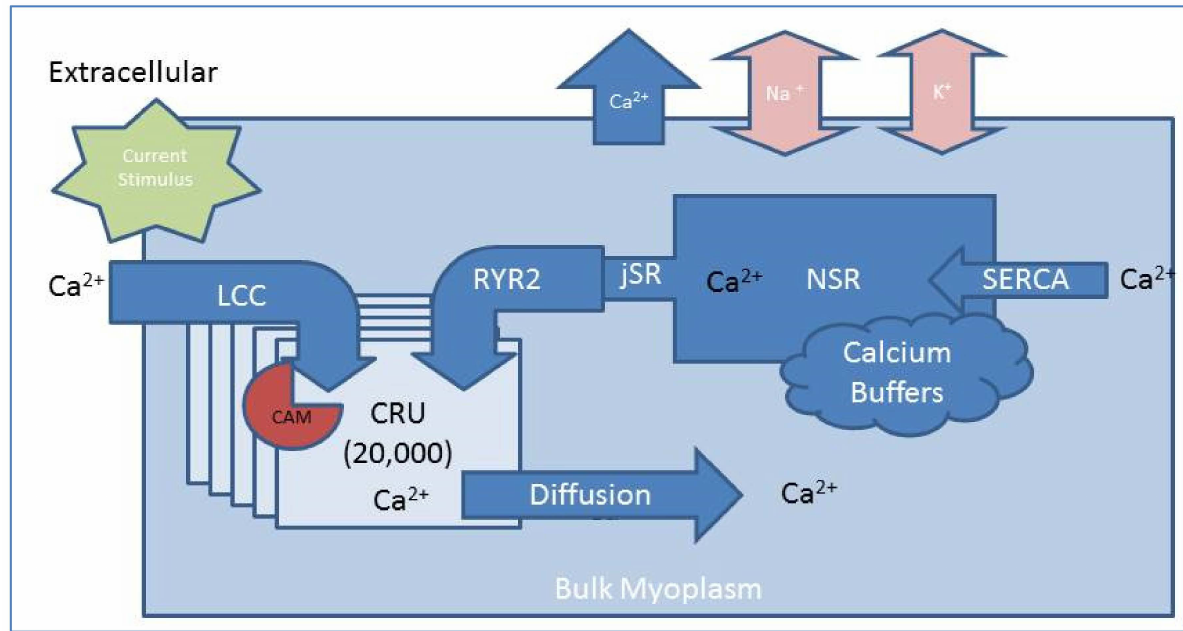
Figure 2. Compartmental model of the cardiac myocyte. A schematic representation of the cardiac myocyte compartmental model, which is parameterized using single channel experimental data, is used to simulate the cellular ionic flux. Calcium enters the cell through 20,000 independent CRUs, first by the L-Type Calcium Channel (LCC) in response to a current stimulus and then through Ryanodine Receptor 2 (RYR2) channels on the surface of the junctional Sarcoplasmic Reticulum (jSR). Calcium influx is terminated by a process dominated by CaM -dependent inactivation the LCC. Calcium diffuses into the bulk myoplasm, where it is reloaded into the non-junctional Sarcoplasmic Reticulum (NSR) by sarcoplasmic/endoplasmic reticulum Ca 2+ -ATPase (SERCA) to diffuse back to the jSR. Additionally, calcium buffers in the bulk myoplasm and NSR account for calcium interactions outside the scope of CICR and cellular ionic homeostasis is maintained by calcium, sodium, and potassium exchangers in the cell